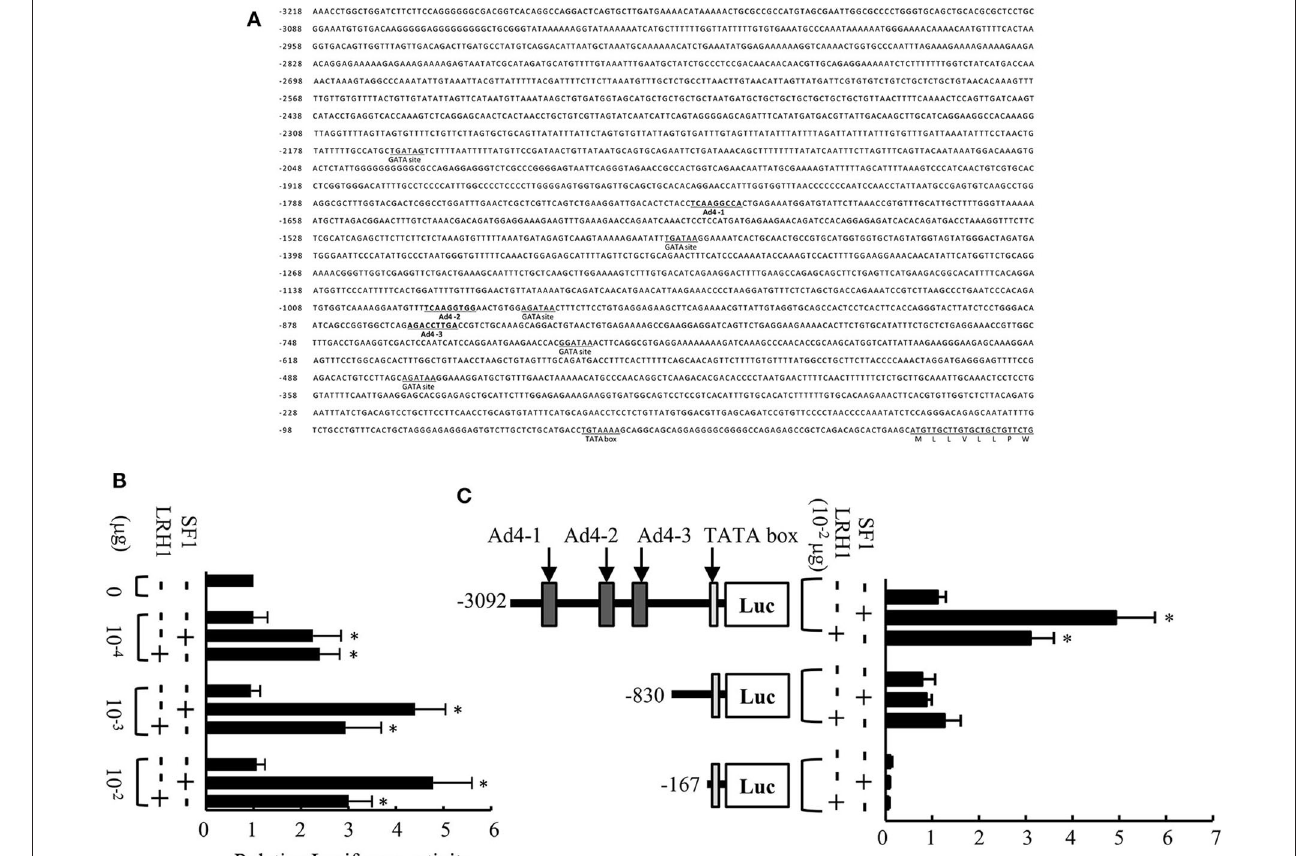
FIGURE 1 | Analysis of the medaka mis promoter. (A) Sequence of the 5 ′ -flanking region of the medaka mis gene. Three Ad4 sites are indicated in bold. (B) Transcriptional activity of the 3.1-kb mis promoter in Hepa-E1 cells. (C) Transcriptional activity of deletion constructs of the mis promoter in Hepa-E1 cells. Relative luciferase (Luc) activity was calculated based on the value of activity in cells transfected without the expression plasmids. Vertical bars indicate means (SEM) of tetraplicates. Significant differences from controls transfected with plasmids lacking steroidogenic factor 1 (SF1) and liver receptor homolog 1 (LRH1) are indicated by * p <